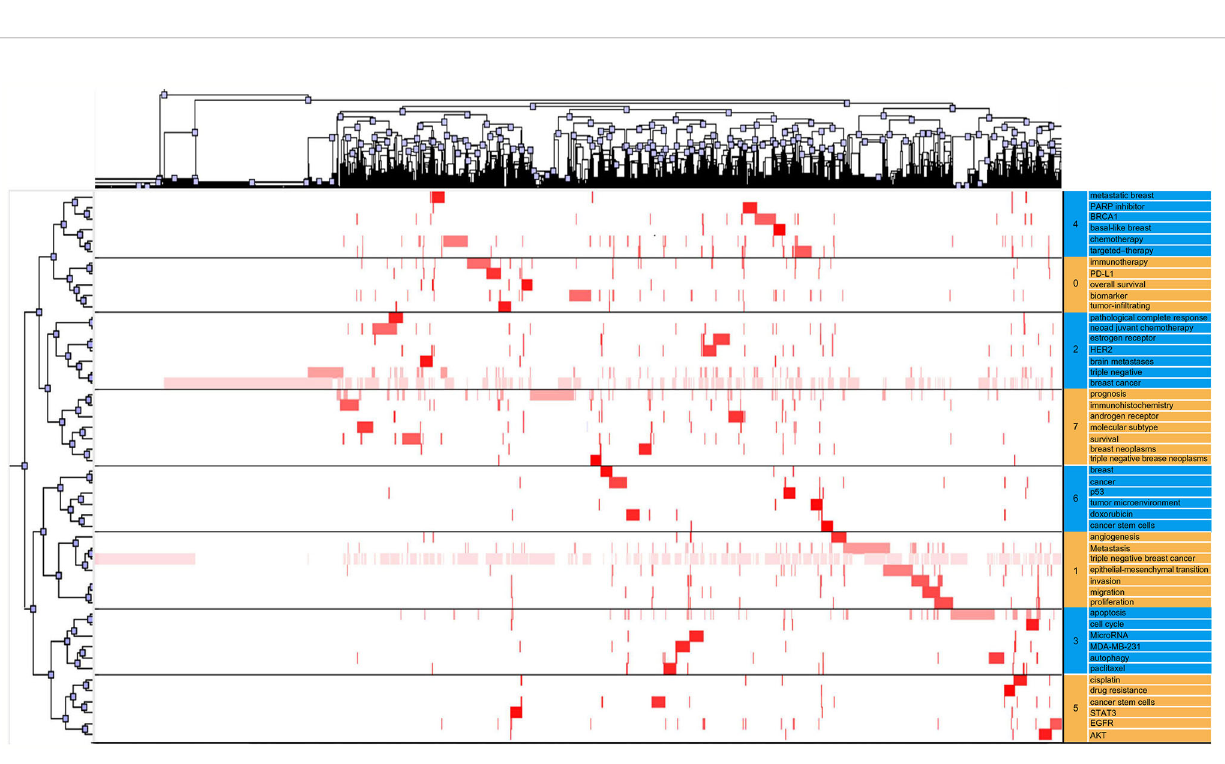
FIGURE 5 | Visualized matrix based on the biclustering analysis of TNBC binary matrix of